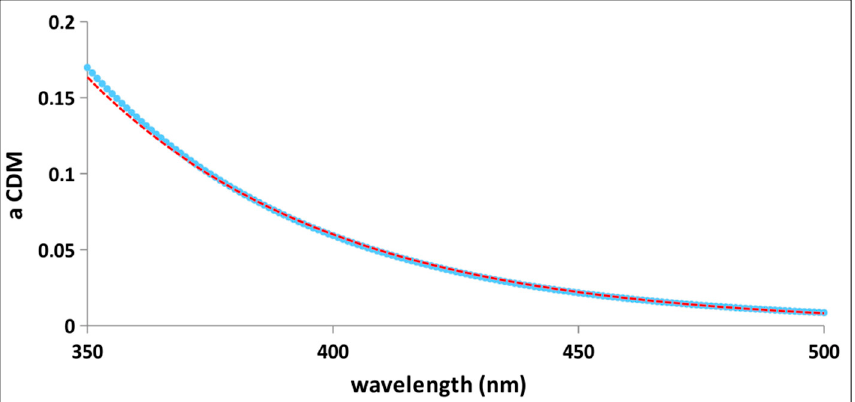
Figure 8. Plot of the averaged a CDM ( λ ) spectrum in the 350–500 nm domain. The dotted red line is the exponential best fit.